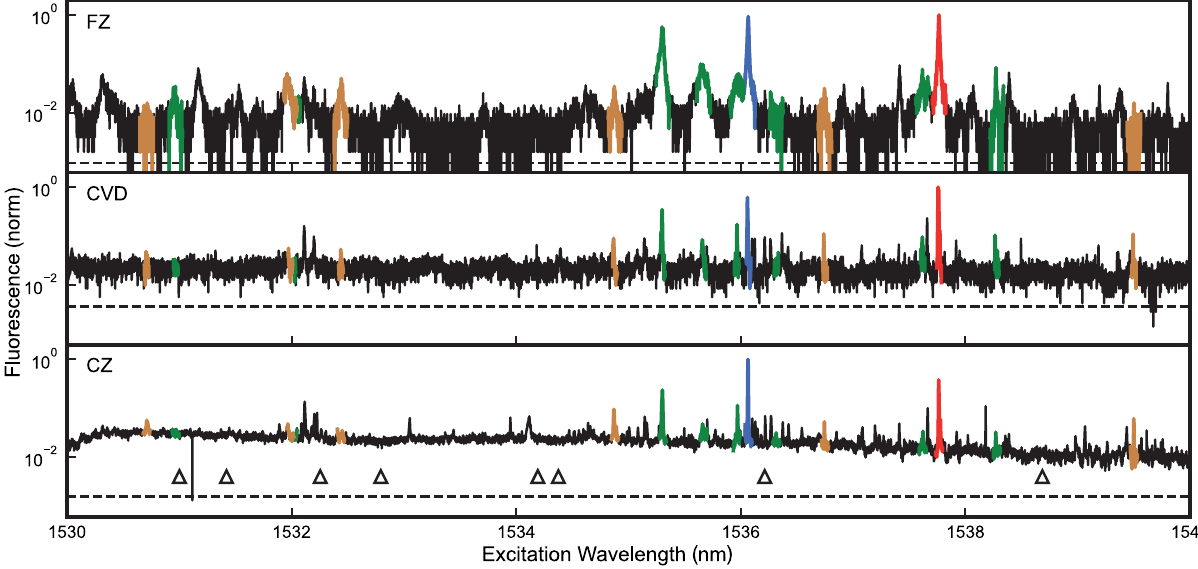
FIG. 9. Comparisonoftheresonantexcitationspectruminthedifferentsampletypes.ComparedtotheCVDandCZsamples,theFZchips exhibit a smaller number of resonant peaks, which is attributed to the higher purity of the starting material. The triangles at the bottom of the third panels indicate different sites that were observed in our earlier work [11], which used different implantation